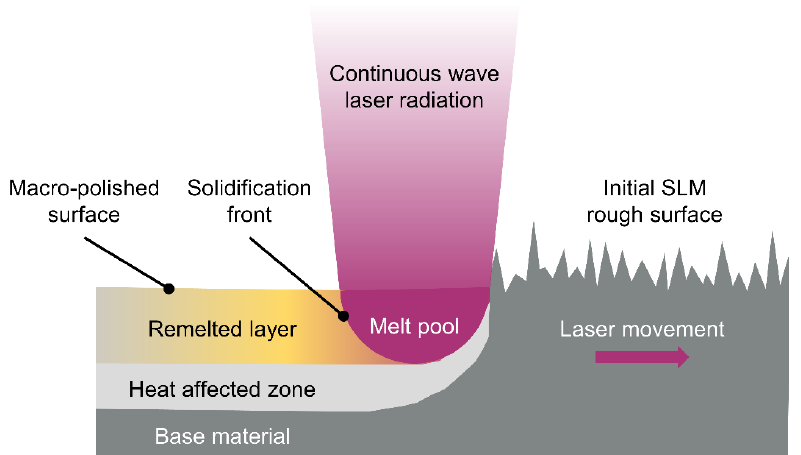
Figure 4. Schematic of laser polishing by remelting a thin surface layer with continuous laser radiation. Redrawn from [118] with permission by CC 4.0.